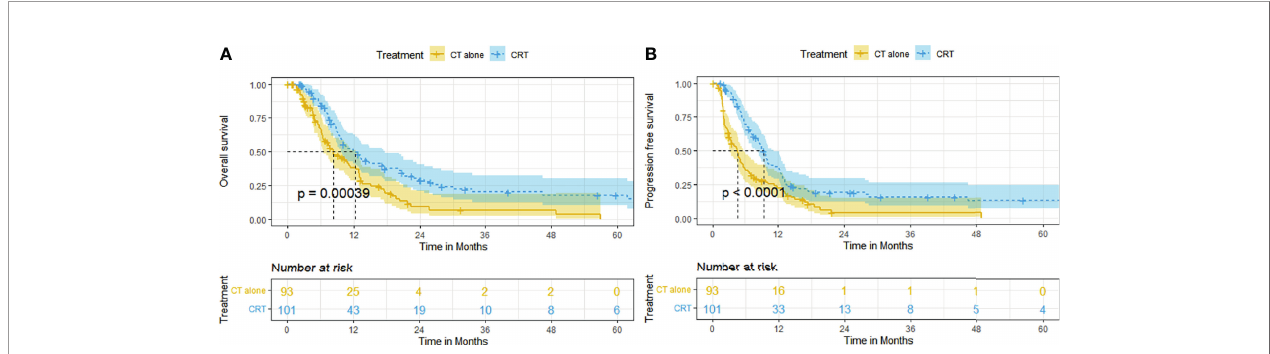
FIGURE 1 | Kaplan – Meier curves of survival in patients with advanced ESCC treated with CRT and CT before PSM: (A) overall survival before PSM; (B) progression-free survival before